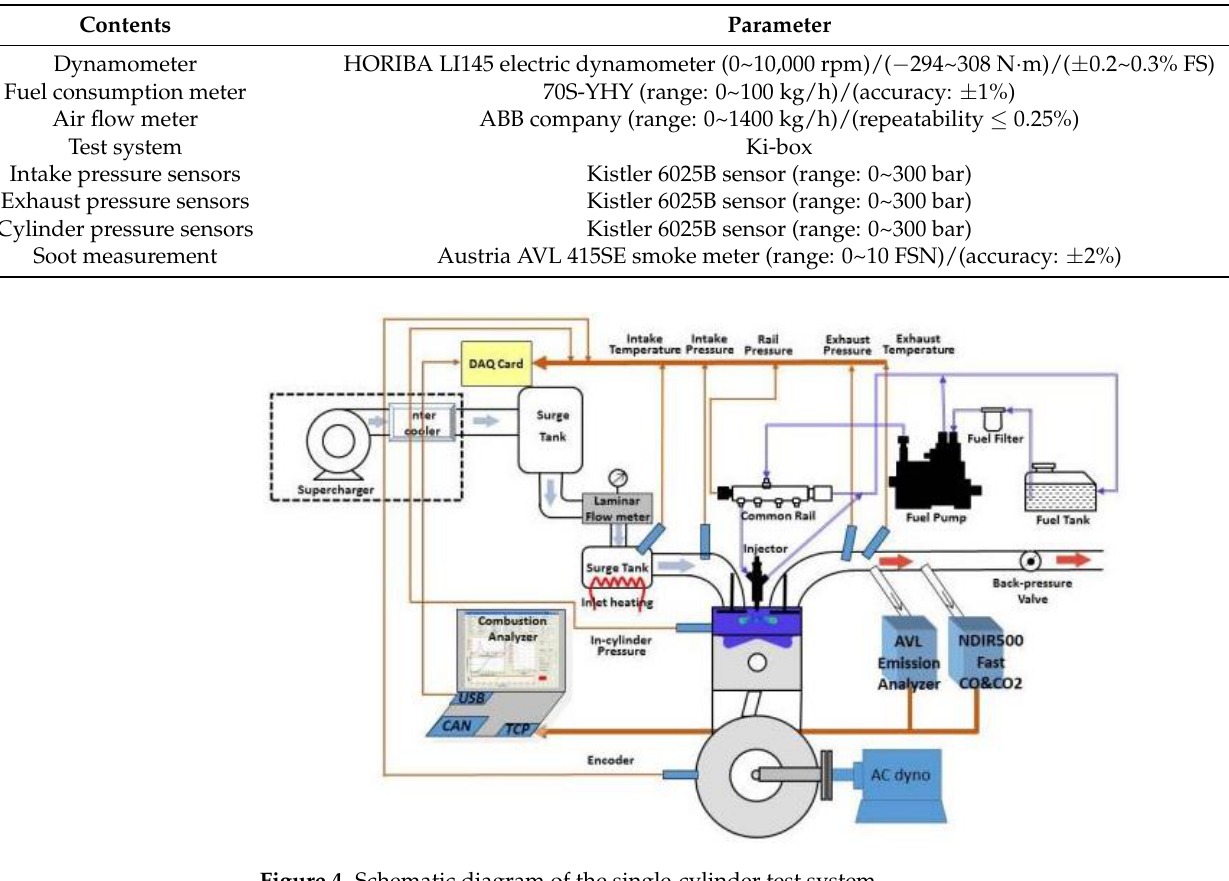
Table 3. Time step of simulation. Table 4. Test system components.